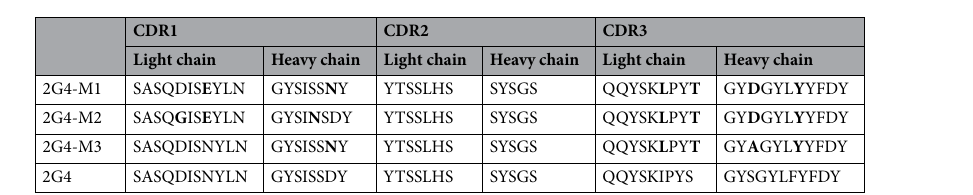
Table 2. Amino acid sequences of the CDRs of 2G4 and